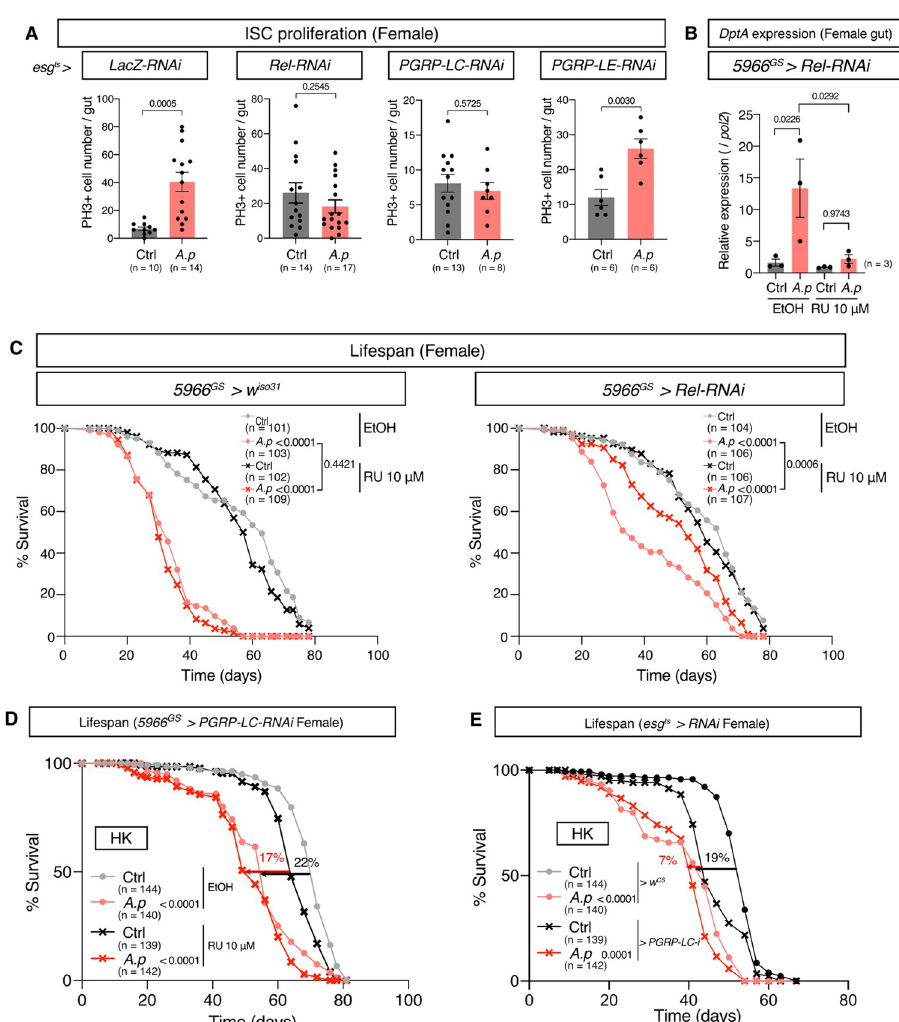
Fig 8. PGRP-LC in the gut promotes ageing by A . persici . (A) Phospho-histone H3-positive cell numbers in the midgut of 4-week-old female flies with BacD. The flies used were Su(H)GBE-LacZ; esg-Gal4 , tub-Gal80 ts , UAS-GFP > LacZ-RNAi , Rel-RNAi , PGRP-LC-RNAi , and PGRP-LE-RNAi , and the flies were reared at 30˚C from their adult day2-4. Unpaired two-tailed Student’s t test was used. (B) Quantitative RT–PCR of DptA in female 5966 GS > Rel- RNAi fly gut after 24 hours of BacD with ethanol or 10 μ M RU. For the statistics, ANOVA with Holm-Sˇı´da´k’s multiple comparison was used. (C) Lifespan of female 5966 GS > Rel-RNAi flies treated with BacD and ethanol or 10 μ M RU. A log-rank test was used to compare between control (Ctrl) and BacD with ethanol or 10 μ M RU. (D) Lifespan of female 5966 GS > PGRP-LC-RNAi flies with heat-killed (HK) diet and ethanol or 10 μ M RU. A log-rank test was used to compare between control (Ctrl) and HK diet with ethanol or 10 μ M RU. (E) Lifespan of female esg ts > w CS and esg ts > PGRP-LC-RNAi flies with HK diet. Flies were reared at 30˚C during their adult period. A log-rank test was used to compare between control (Ctrl) and HK diet in each genotype. The 50% survival rate is compared in (D) and (E). The control diet in (A-C) followed the same procedure for BacD but it has only MRS broth in place of bacterial isolates, resulting in the antibiotics-contained diet. The control diet in (D) and (E) is the antibiotics-contained diet. Sample sizes (n) and P values are in each